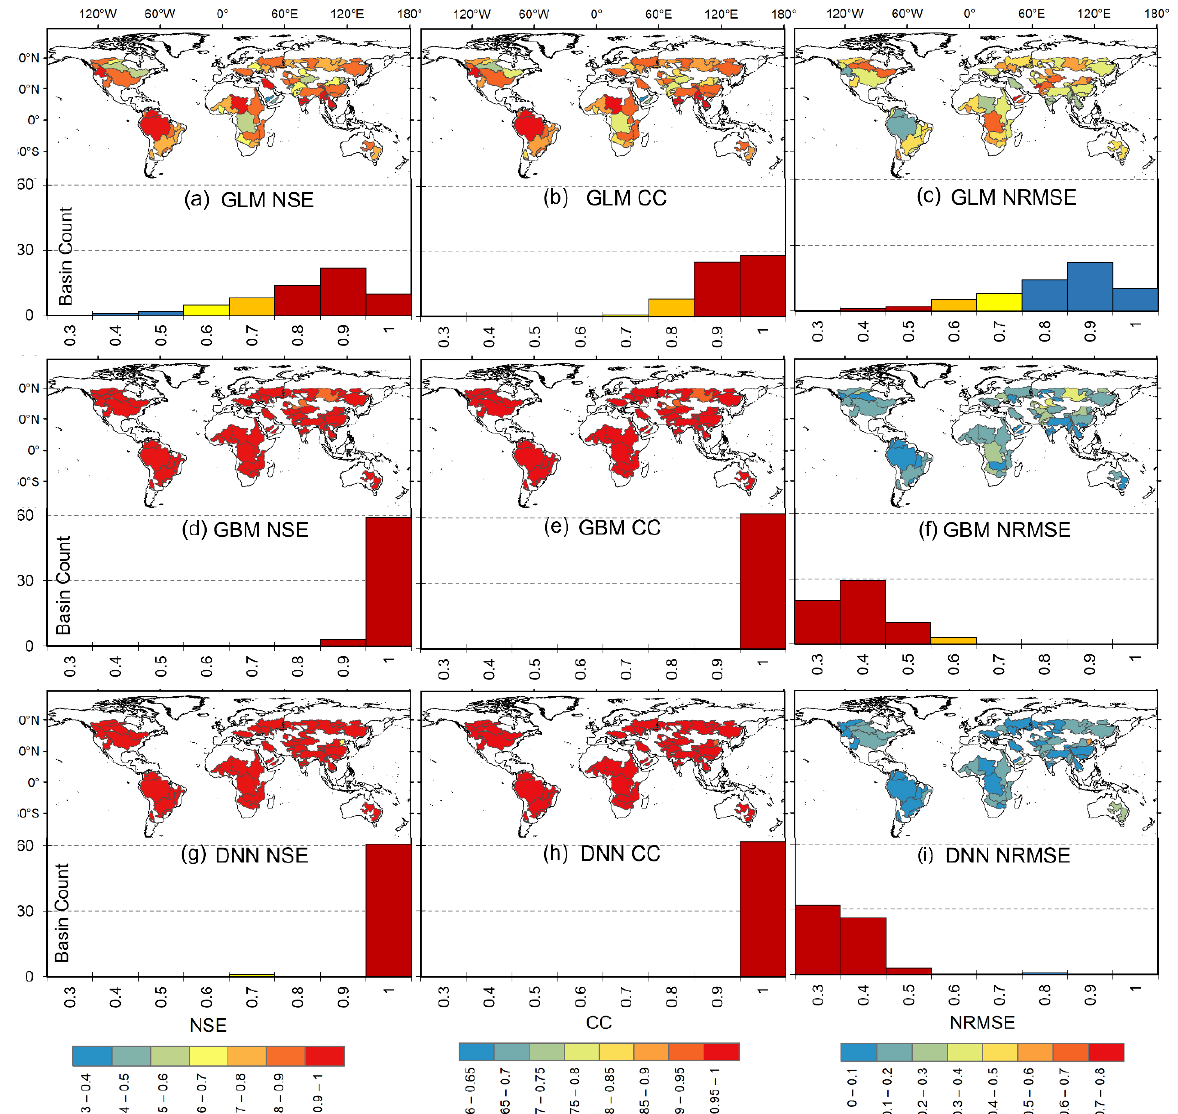
Figure A2. Spatial (maps) and frequency (bar plots) distributions of the basin-scale training perfor- mance for the ( a – c ) GLMs, ( d – f ) GBM models, and ( g – i ) DNN models. The color-coded frequency distribution shows the very good (red), good (orange), satisfactory (yellow), and poor (blue) perfor- mance categories.